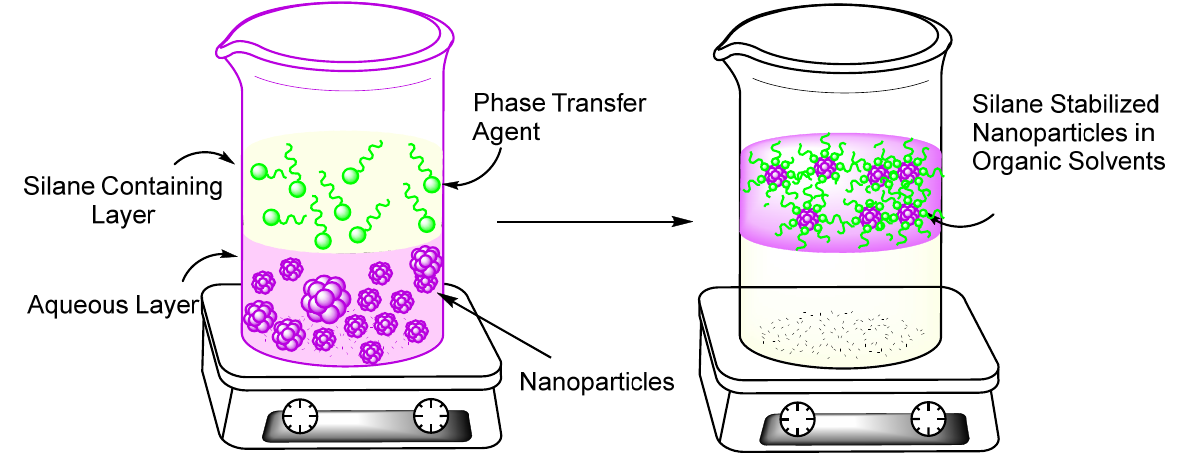
Figure 1. A schematic representation of the phase transfer process.